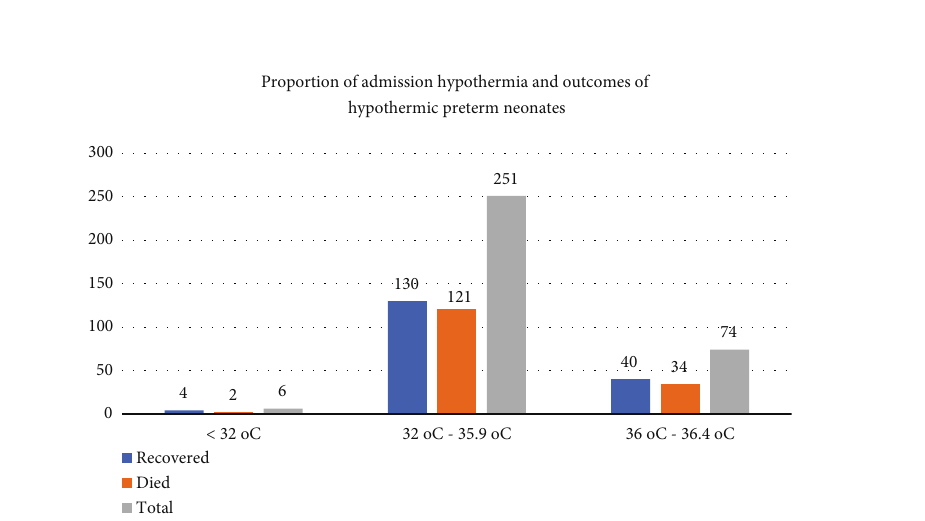
Figure 2: Proportion of admission hypothermia and outcomes of hypothermic preterm babies admitted in Addis Ababa public hospitals from 2018 to 2021, Addis Ababa, Ethiopia,